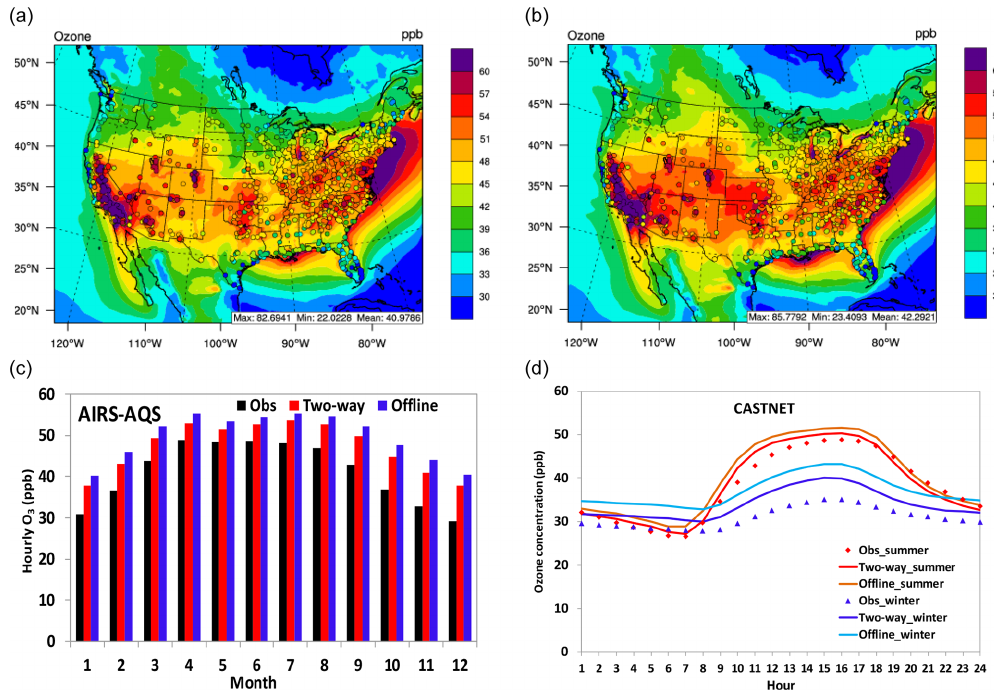
Figure 9. Spatial distributions of 5-year averaged max 8h O 3 in summer overlaid with observations from AIRS-AQS and CASTNET for (a) two-way WRF-CMAQ and (b) offline CMAQ. (c) Bar chart for 5-year average monthly O 3 between observations (black bar), two-way WRF-CMAQ (red bar), and offline CMAQ (blue bar). (d) Diurnal plots of observed (dots) vs. simulated (lines) hourly O 3 concentrations against CASTNET for winter (cold colors) and summer (warm colors) in